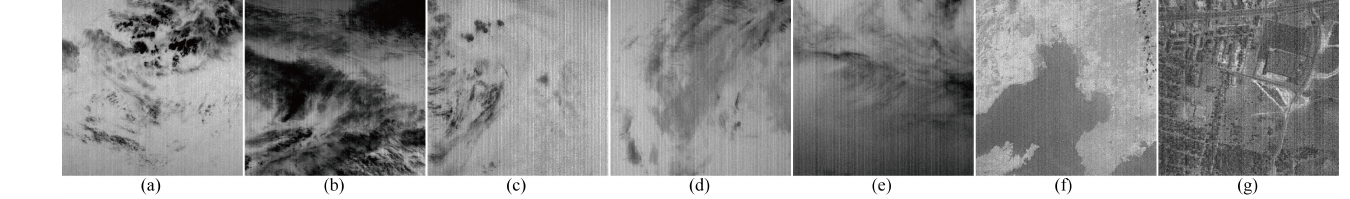
Figure 6. Eight real-life images respectively from Aqua MODIS data (( a – c ) named as RAM1 , RAM2 , and RAM3 ), Terra MODIS data (( d – f ) named as RTM1 , RTM2 , and RTM3 ), and Hyperspectral (( g ) urban )